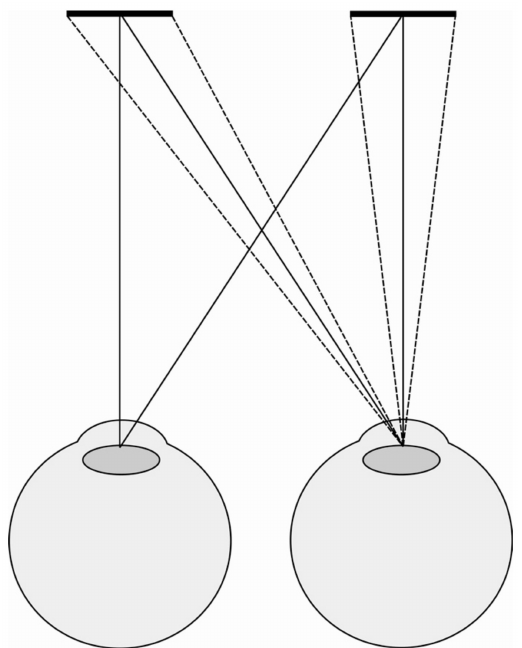
Figure 10. Differences in retinal projections for the left and rights coins in the right